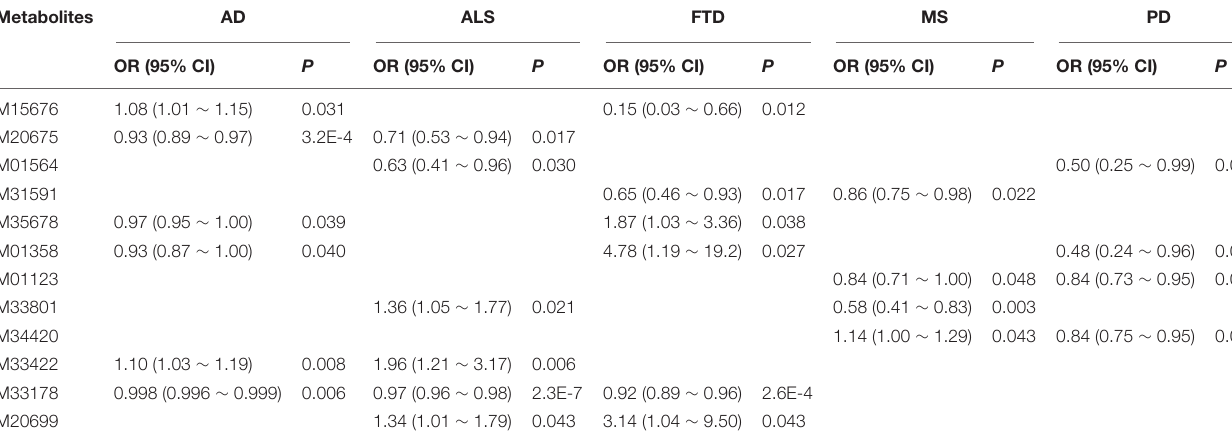
TABLE 2 | Overlapped known metabolites existing causal association with at least two neurodegenerative diseases. Metabolites